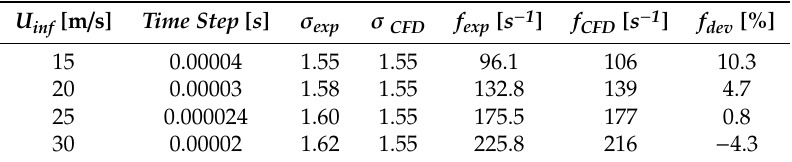
Table 3. Numerical and experimental shedding frequency results for the various flow conditions and numerical.